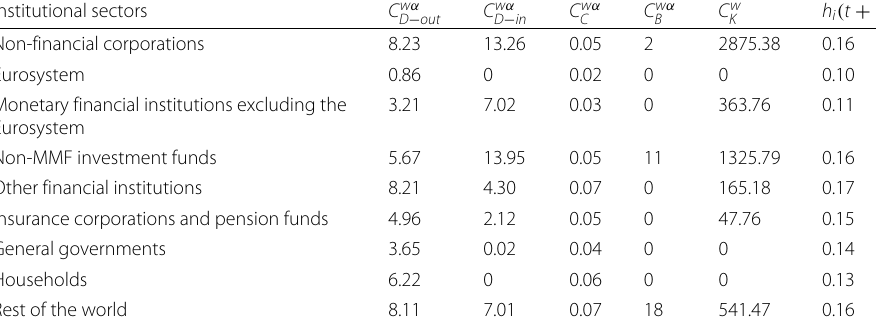
Table 4 Network statistics - equity